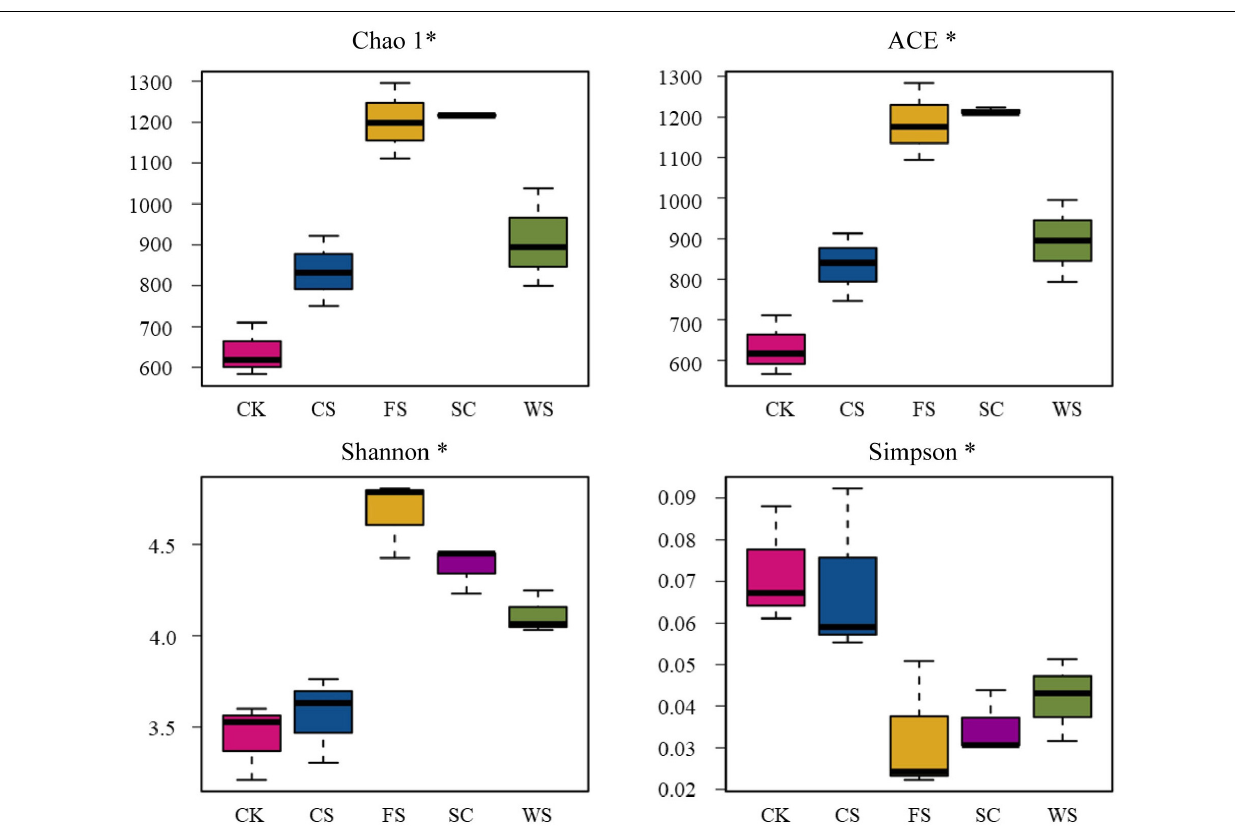
Humicola, Periconia, Pseudonymnoascus, and